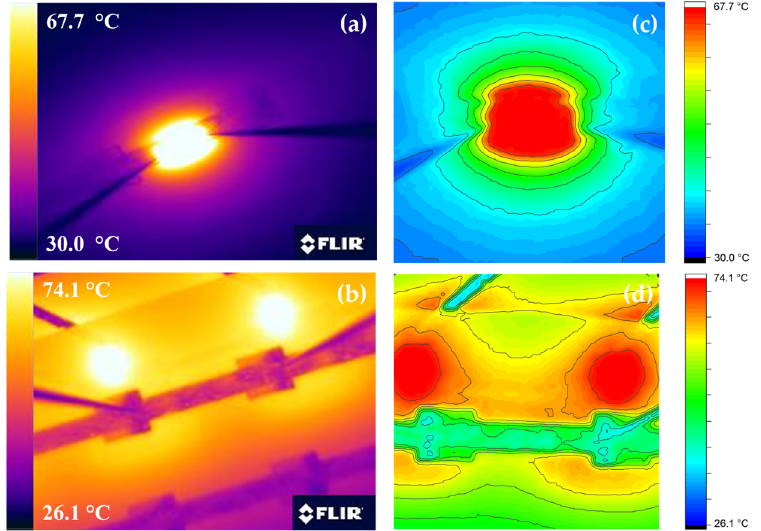
Figure 5. IR images and thermal contour plots ( a , c ) for self-heated case; ( b , d ) external heating implementation. Hot spots created by the external heaters are visible, but uniform on-sample temperature distribution is achieved.